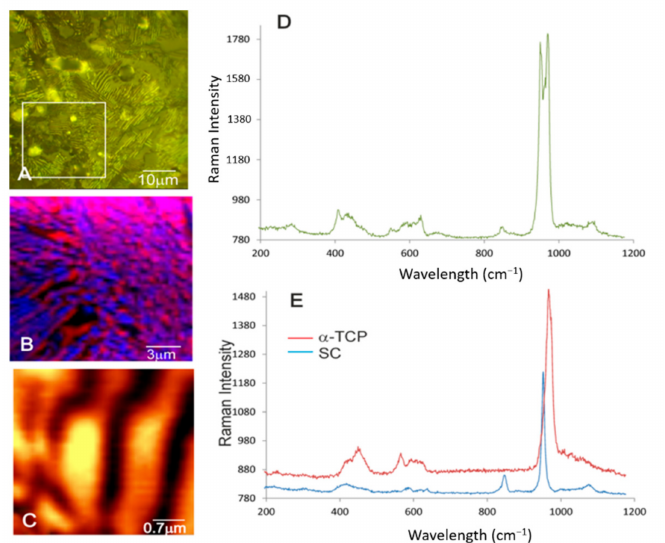
Figure 4. ( A ) Confocal optical micrograph of the scaffold cooled at 50 ◦ C/h as being a representative sample. ( B ) Raman image of the area selected in ( A ) in which phases SC and α -TCP are represented in colors and display an irregular eutectoid pattern. ( C ) A Rayleigh light-scattering microscopy image showing a nanostructured sinusoidal disordered pattern. ( D ) The average Raman spectra from the scaffold. ( E ) Single-phase dense ceramics of SC and α -TCP for comparison purposes.